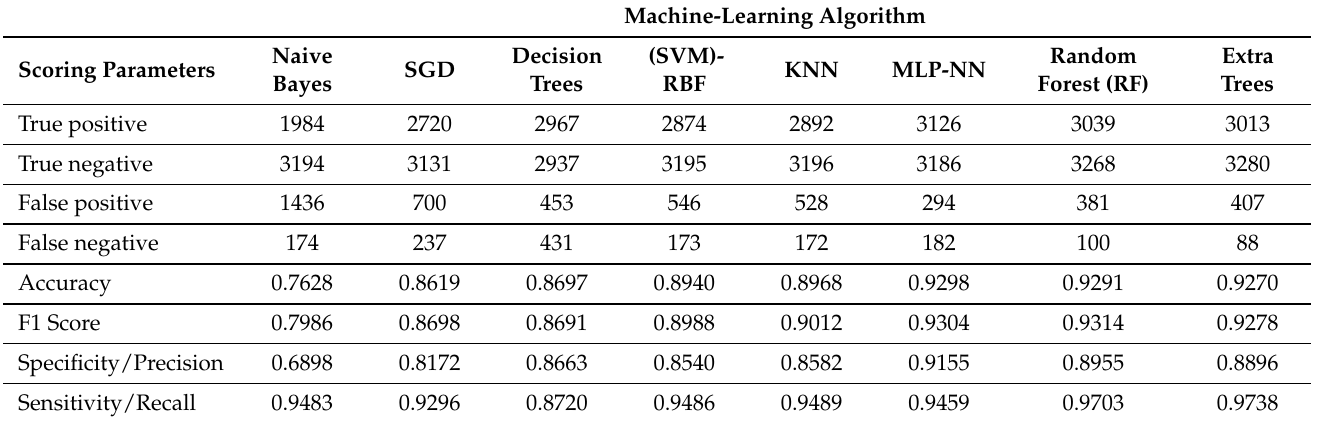
Table 2. Scoring parameters of the ML algorithms evaluated in this study. Machine-Learning Algorithm